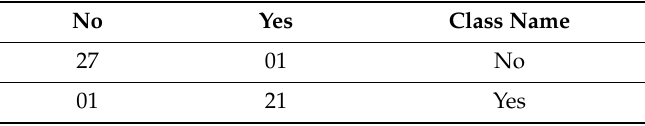
Table 12. Matrix with reduced dimensions for fold